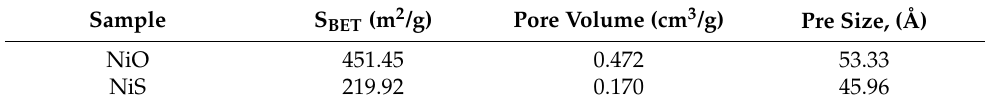
Figure 12. SEM ( A ) and EDX ( B ) of NiO; and SEM ( C ) and EDX ( D ) of NiS. Table 7. Specific surface area and porosity parameters of NiO and